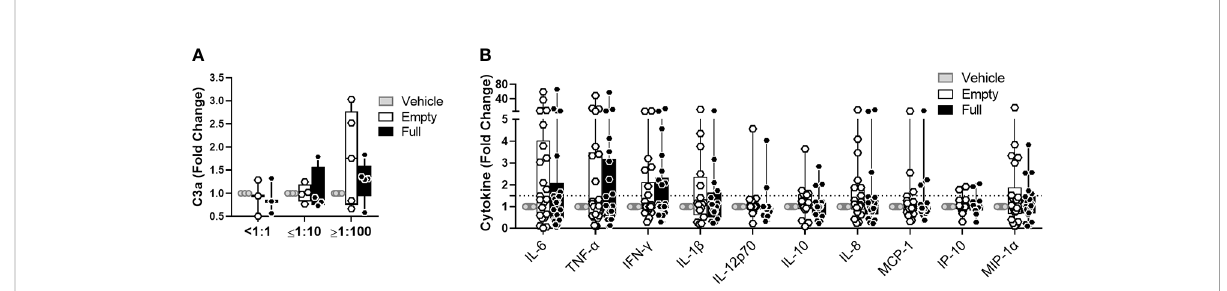
FIGURE 6 Empty vectors induce similar response to full vectors in whole blood assay. (A) C3a levels in human serum treated with 5×10 11 vg/mL of AAV- Spark100-GLuc ‘ full ’ or 5×10 11 of AAV-Spark100 ‘ empty ’ capsid/mL or vector vehicle for 90 minutes. (B) Cytokine and chemokine secretion from whole blood stimulated with 1×10 11 vg/mL of AAV-Spark100-hFIX ‘ full ’ or 1×10 11 AAV-Spark100 empty capsid/mL or vector vehicle for 24 hours. Samples were categorized based on their titers of anti-AAV-Spark100 neutralizing antibodies as indicated under x axis. Bars represent mean fold-change ± SEM of AAV relative to unstimulated cells. Symbols represent values of each sample. Dashed lines signify a 1.5-fold positivity cutoff. Signi fi cance was determined with the Holm-Sidak method and showed no signi fi cant changes.